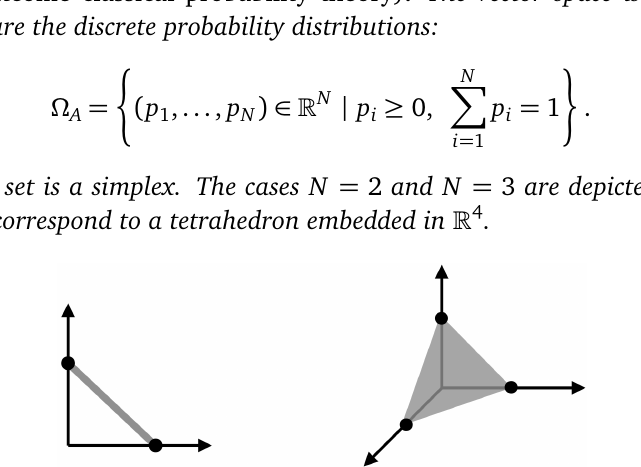
A A is depicted in gray). Left: the classical bit